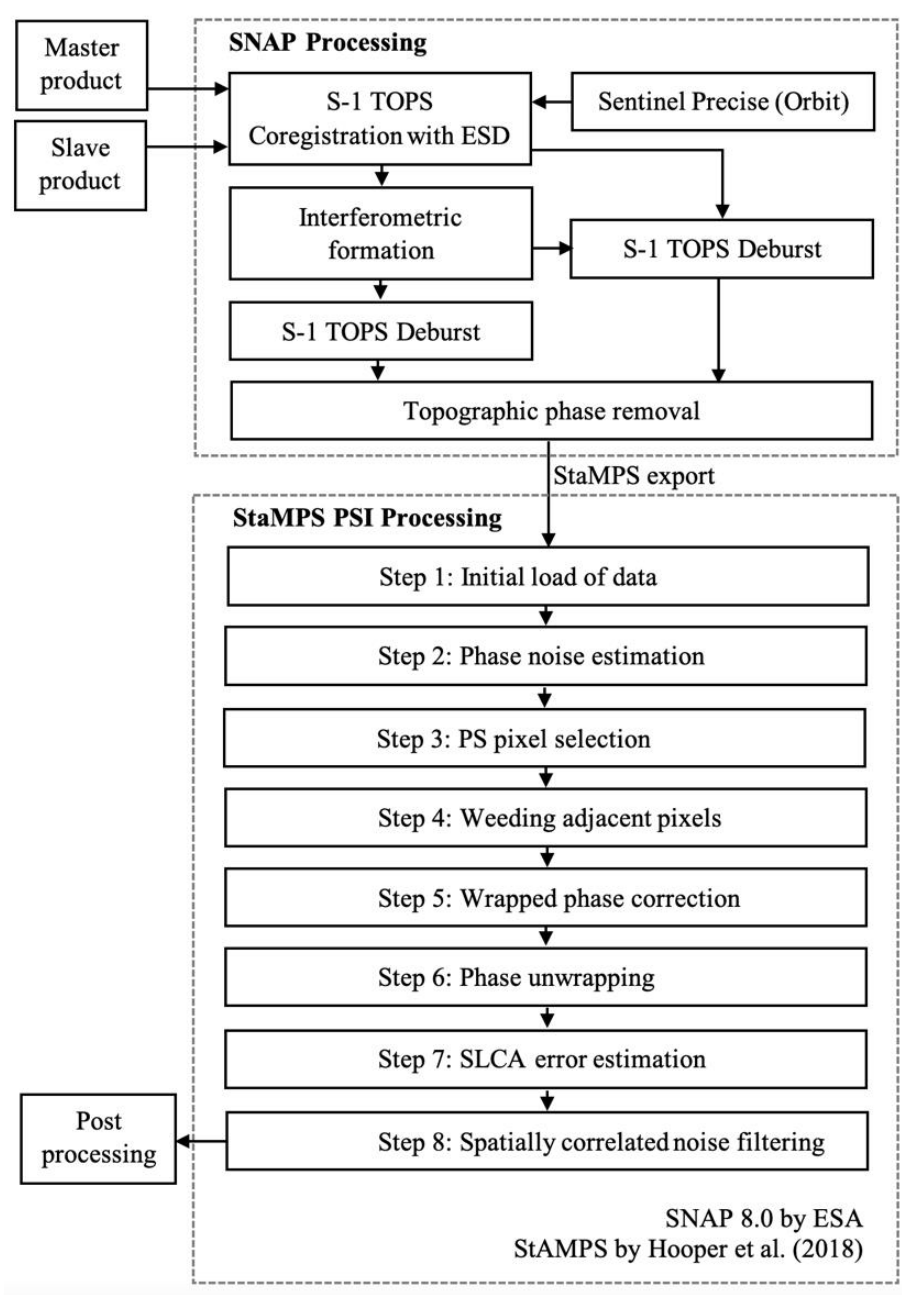
Figure 4. Standard PSI workflow using SNAP and StaMPS by [42]. The SBAS method is comparable to the PSI method with the key difference in the pairing of InSAR images. The SBAS method produces differential interferograms from all the input InSAR images stacked with varying pairing combinations that fulfil the criteria of temporal and geometric baseline, whilst the PS method assigns one reference InSAR image to be paired with all secondary InSAR images. The SBAS processing using the combined SNAP and StaMPS workflow is shown in Figure